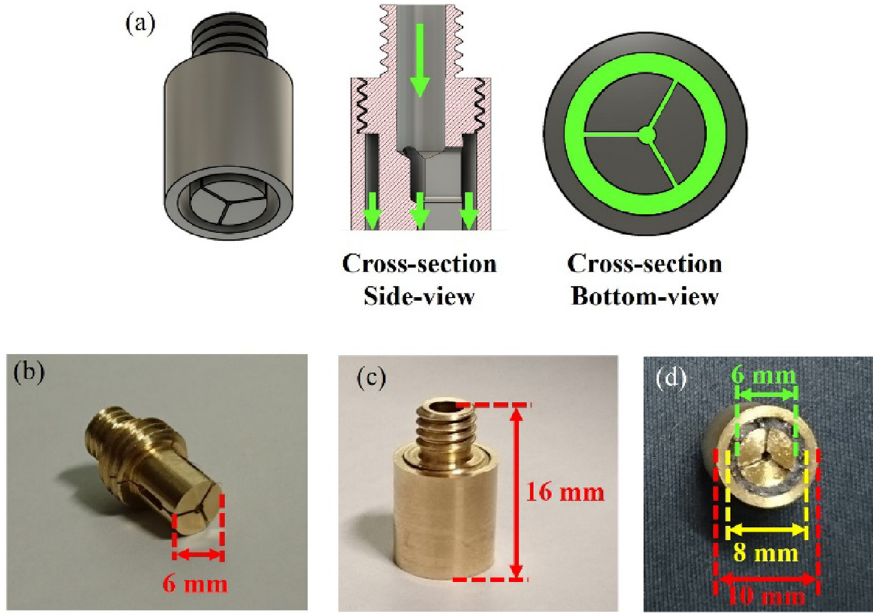
Figure 5: ( a ) Structured nozzle design. Green arrows and green colors represent the direction of fi lament moving and cross section of extruded polymer from the structured nozzle. ( b – d ) Micromachined structured nozzle: ( b ) body, ( c ) body + cover, and ( d ) after MPOF drawing. From ref. ( 91 ) , originally published under a CC 4.0